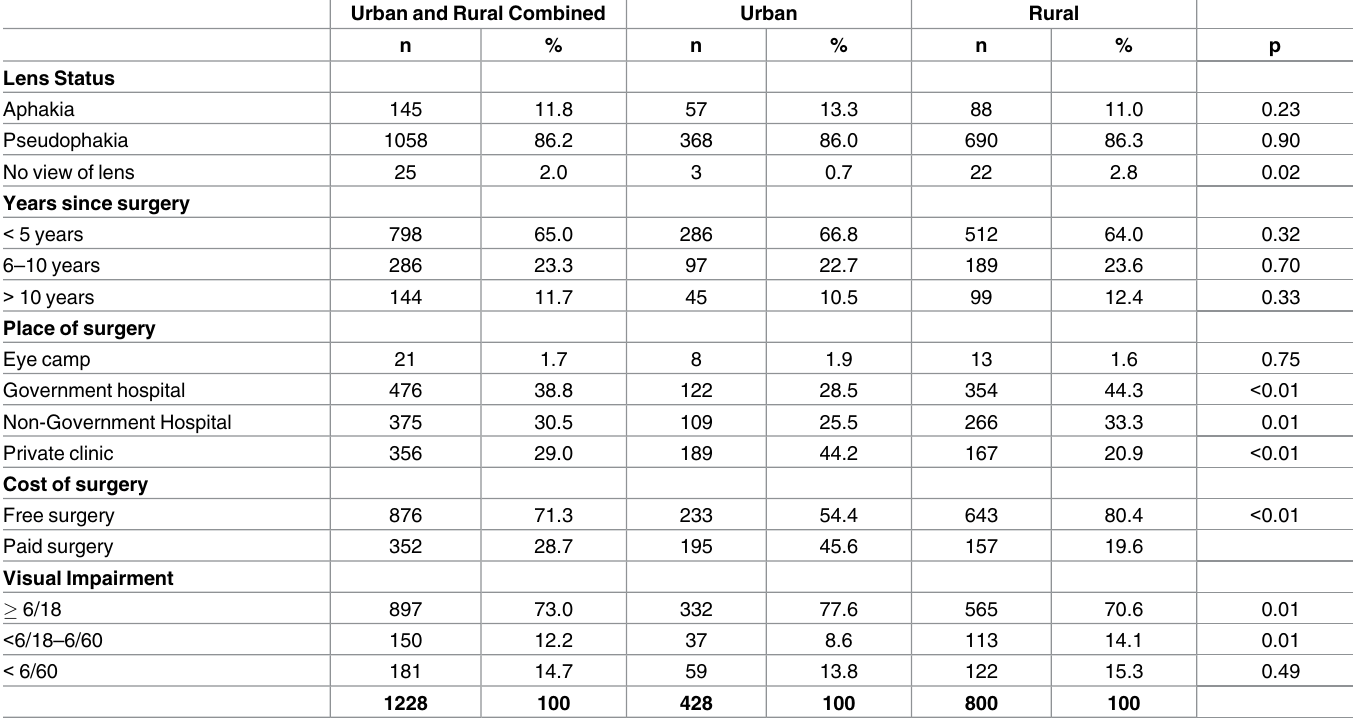
Table 2. Characteristics of the Operated eyes (n = 1228).